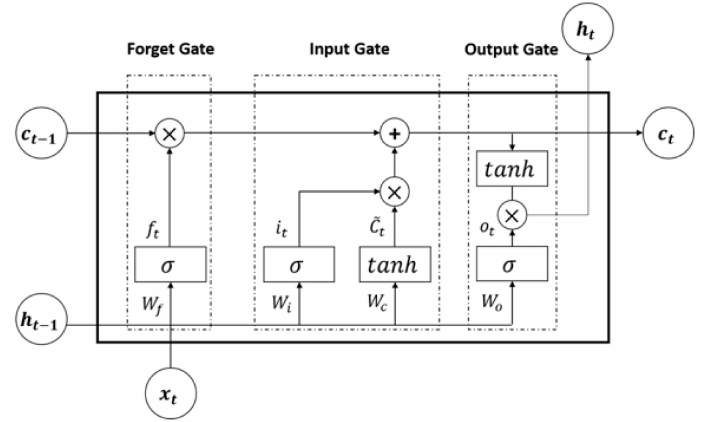
Figure 8. Schematic of a unit LSTM